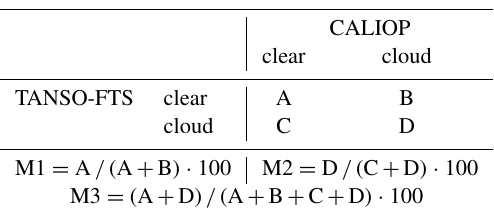
Table 2. Definition of the matching ratio between the TANSO-FTS cloud flag and